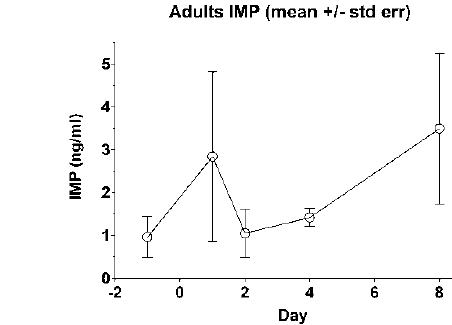
Figure 3. Time-concentration profile for urinary IMP measurements among child and adult PET study participants following an outdoor granular turf pesticide